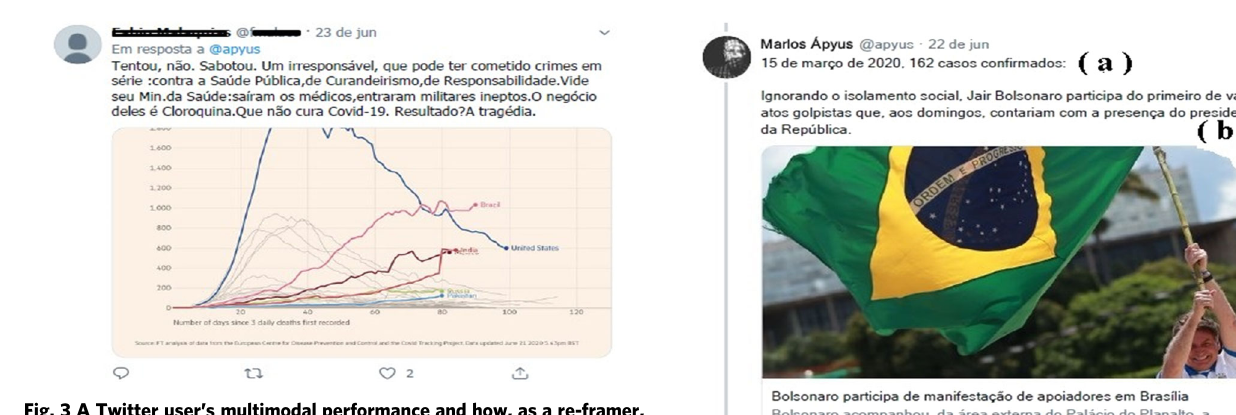
Fig. 3 A Twitter user ’ s multimodal performance and how, as a re-framer, that user views the Covid-19 virus. Translation : Tried, no. [He has] sabotaged. An irresponsible [president], who might have committed a succession of crimes: against Public Health, charlatanism, [and a presidential crime of] responsibility. See his Ministry of Health: the medical doctors left, and the inept military men stepped in. Hydroxychlroroquine is their business. That does not cure Covid-19. Aftermath? The tragedy.